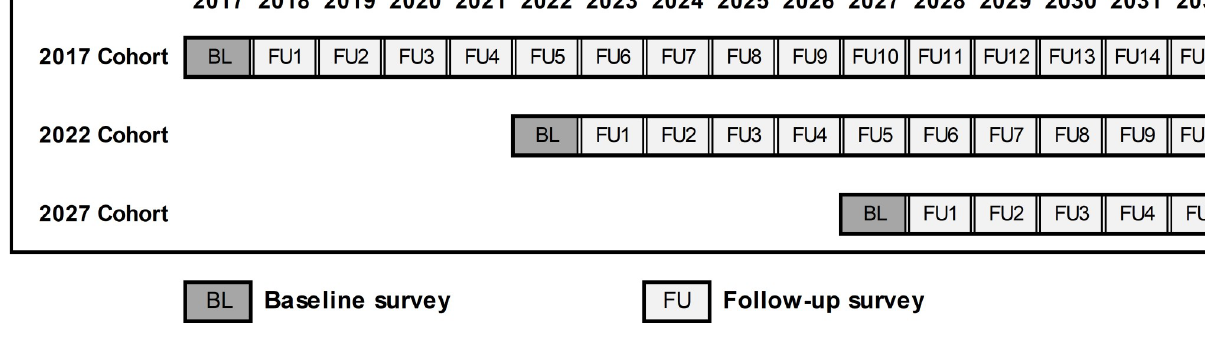
Fig 1. Overview of WISDOM study